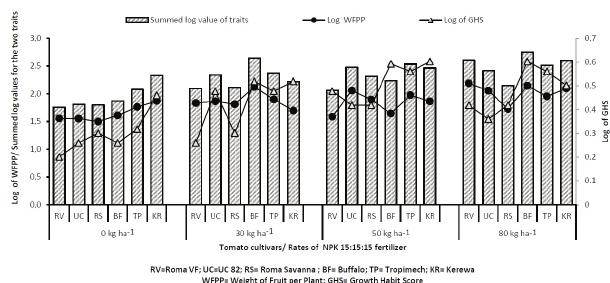
Fig. 2 ­ Comparison of growth habit and weight of fruit per plant for identification of tomato cultivar with better combina­ tion of traits under different fertilizer rates.